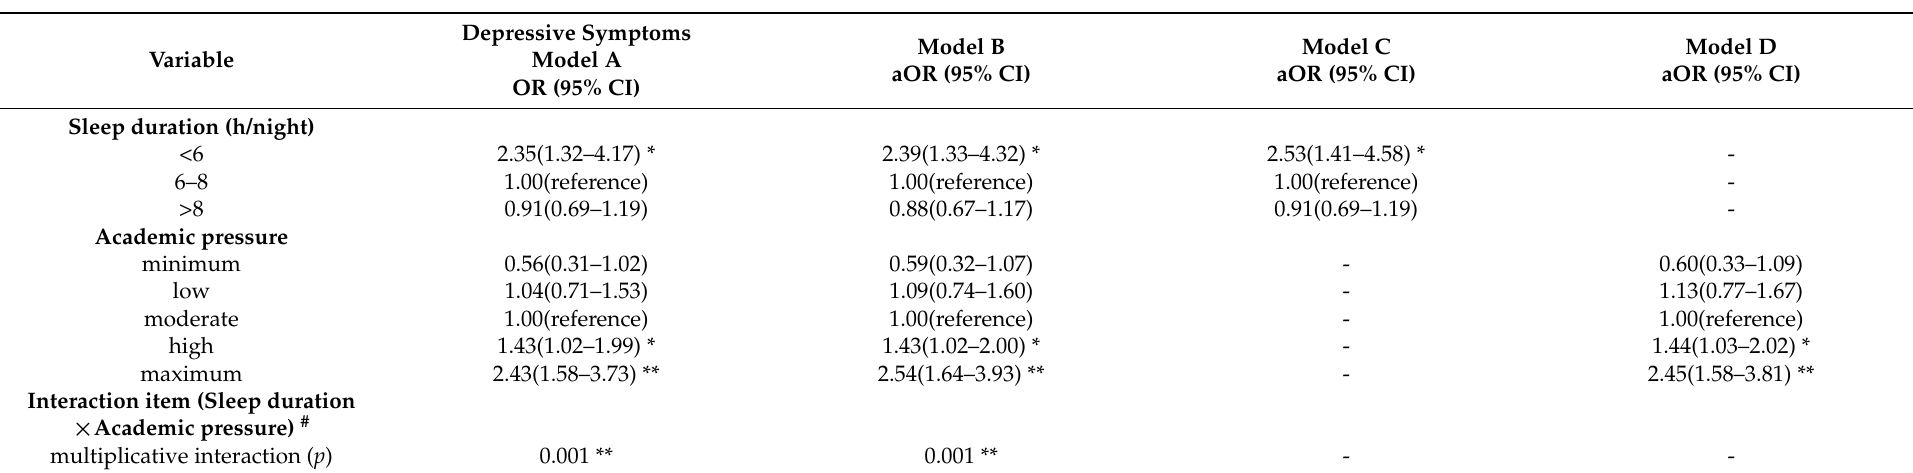
Table 2. Respective association of sleep duration, academic pressure, and their interaction item with depressive symptoms.